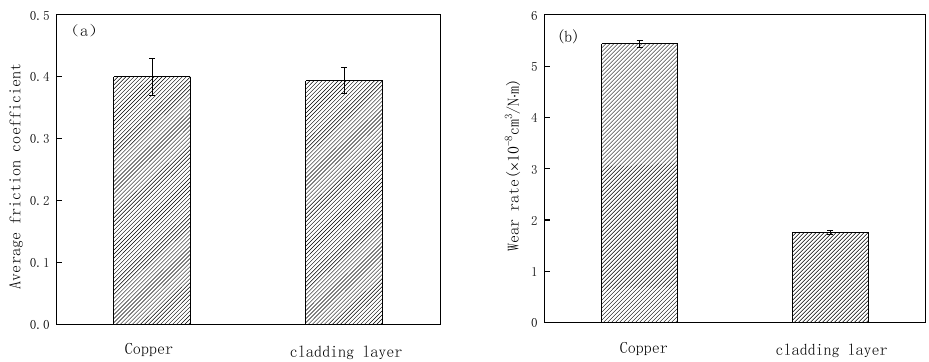
Figure 8. The average friction coefficient ( a ) and the average wear rates ( b ) of the coatings and the matrix.